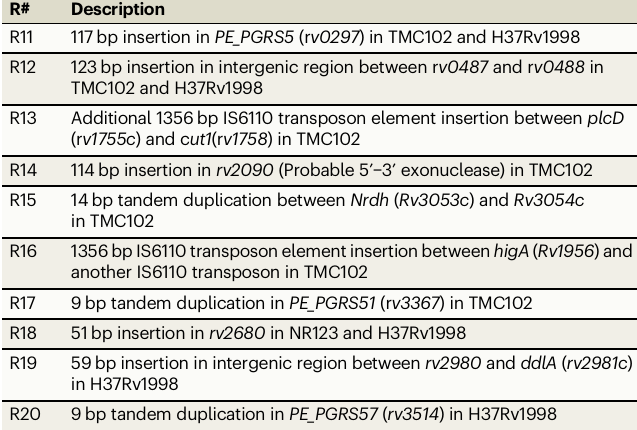
Table 2 | Description of differences between the newly sequenced and de novo assembled H37Rv strains, TMC102, NR123 and H37Rv1988 identi fi ed by